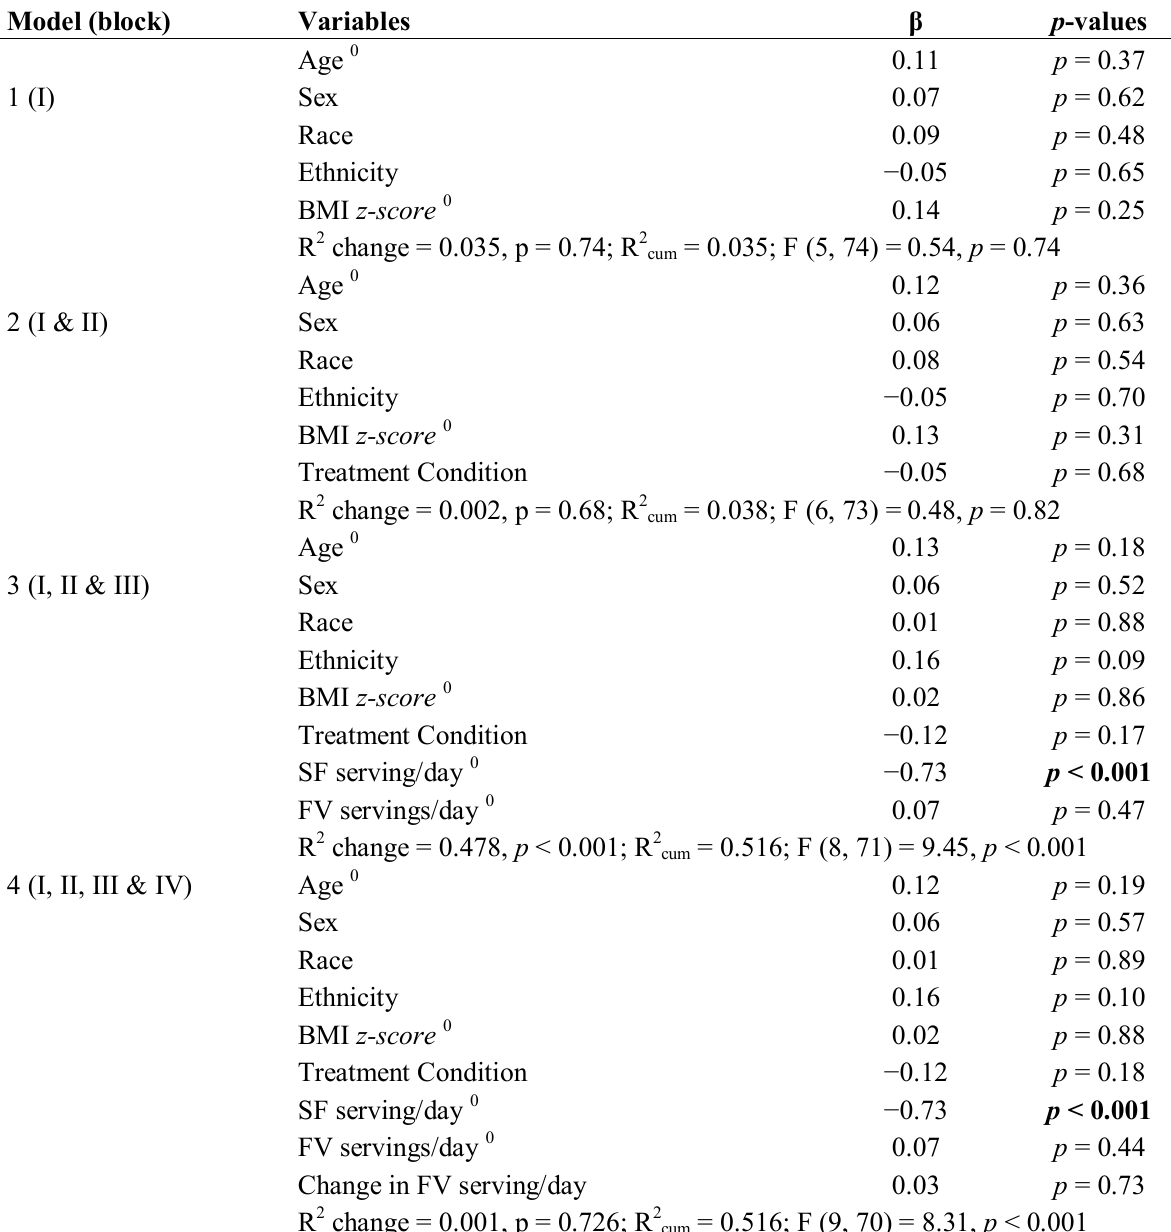
0 baseline values; R 2 change = incremental variance accounted for by each block; R 2 accounted for by the entire